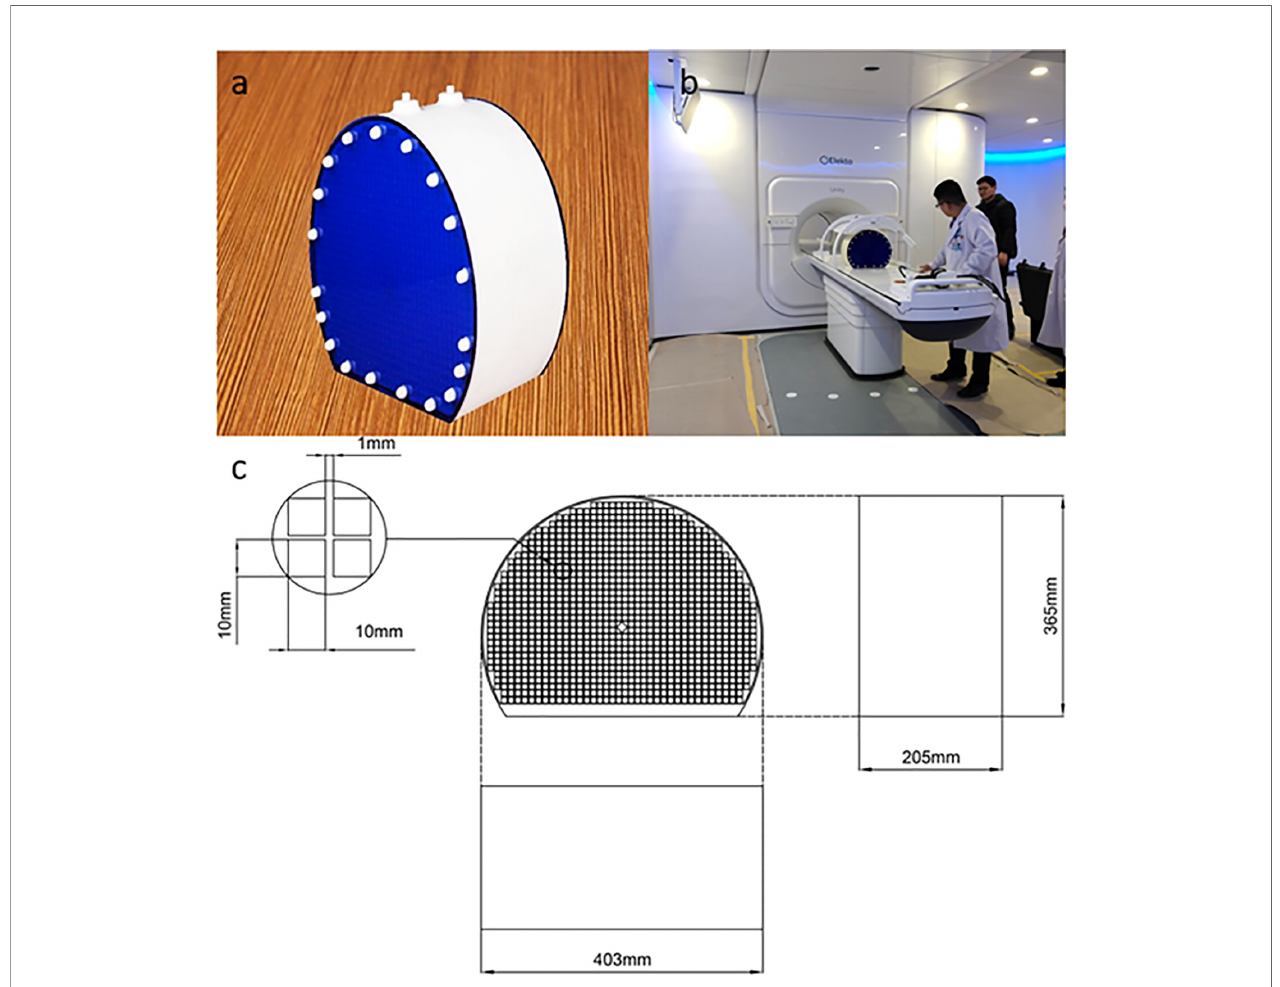
FIGURE 1 | Realistic photo of the 3D printed phantom (A) . The placement of the phantom in Unity before image scanning (B) . The detailed size and structural design of the 3D printed phantom (C)